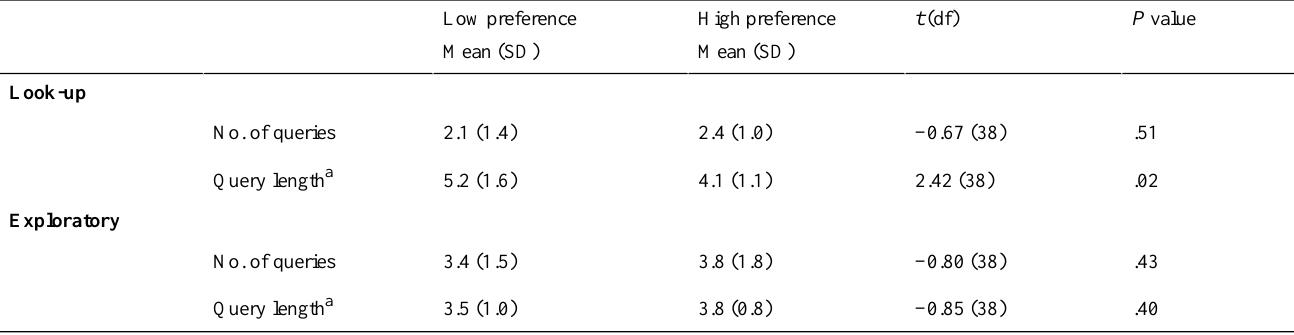
Table 4. Number of queries submitted and query